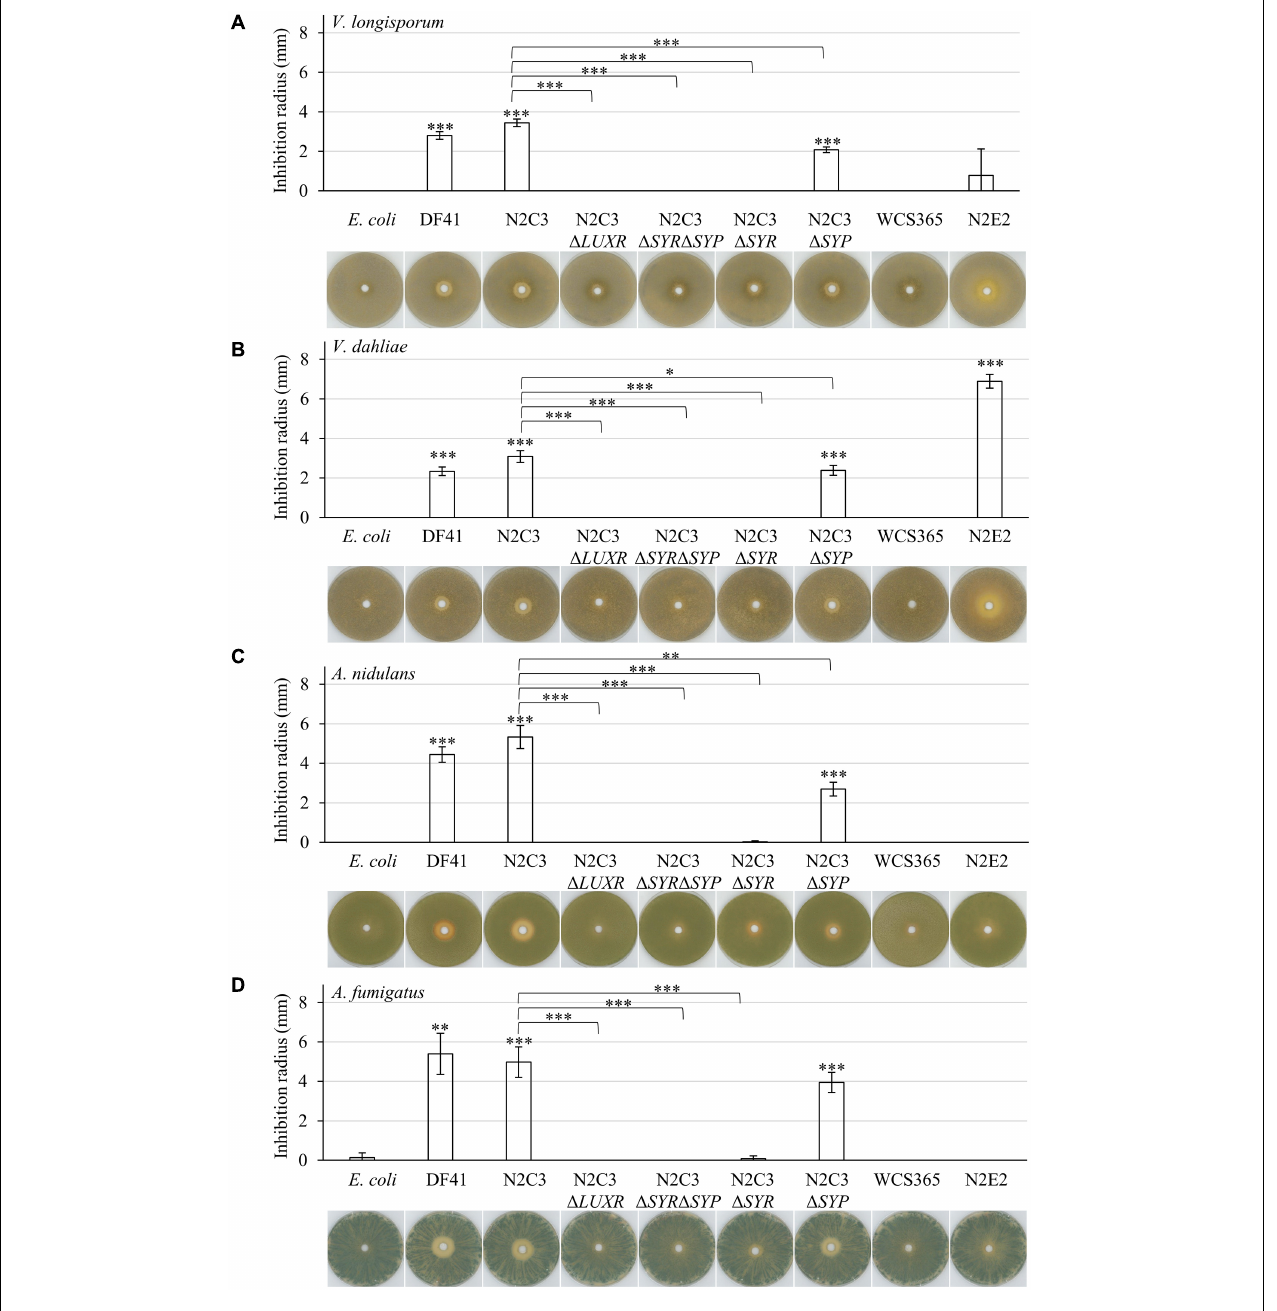
FIGURE 1 | Lipopeptide producing fluorescent pseudomonads inhibit plant pathogenic Verticillium spp. as well as saprophytic Aspergillus spp. Co-cultivation of 1 × 10 5 fungal spores with 7 × 10 7 colony-forming bacteria on pectin-rich simulated xylem medium. Plates were incubated in the light for four days at 25 ◦ C. The following bacterial isolates were used: Pseudomonas brassicacearum DF41 and Pseudomonas sp. N2C3 (cluster for the production of lipopeptides present), N2C3 deletion strains (cid:49) LUXR (neither syringomycin nor syringopeptin synthesis), (cid:49) SYR (cid:49) SYP (neither syringomycin nor syringopeptin synthesis), (cid:49) SYR (no